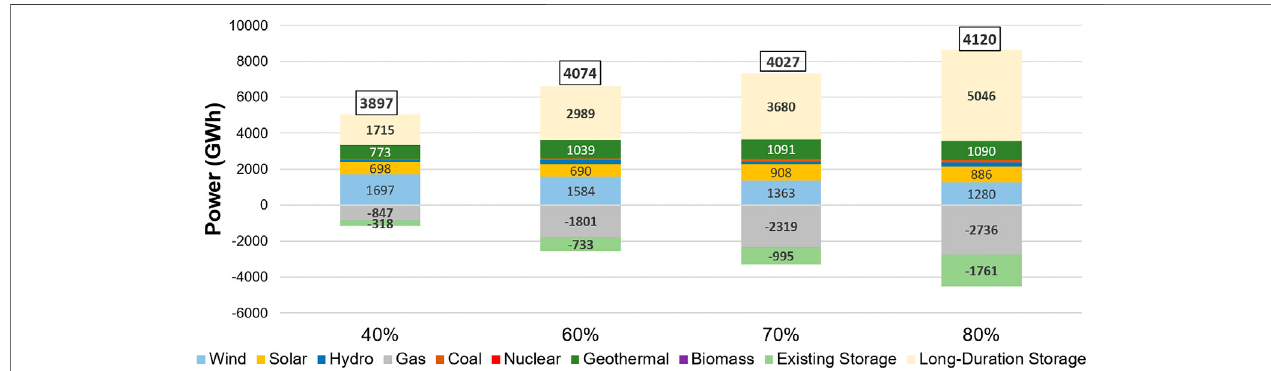
FIGURE 14 | The annual generation mix changes associated with the maximum bene fi t long-duration energy storage including energy storages with (A) 40% round-trip ef fi ciency and 9-day duration, (B) 60% round-trip ef fi ciency and 24-day duration, (C) 70% round-trip ef fi ciency and 30-day duration, and (D) 80% round-trip ef fi ciency and 32-day